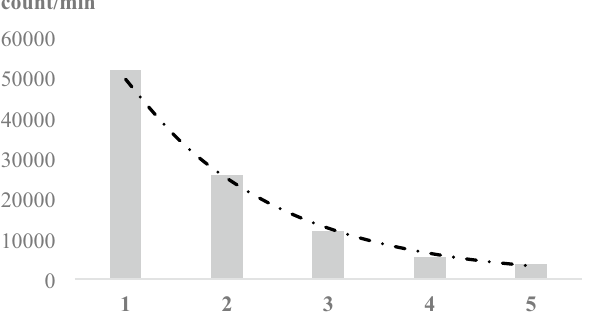
Figure 9. example of a biophoton emission intensity decay with fitted exponential regression curve from the control group, leaf A, R 2 =